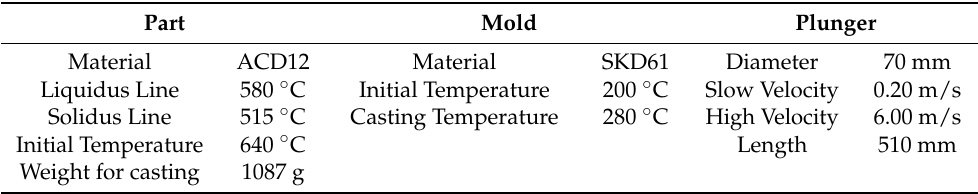
Table 1. Condition for the CAE